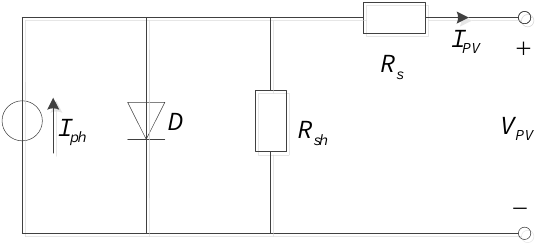
Figure 1. Equivalent circuit of a solar cell.